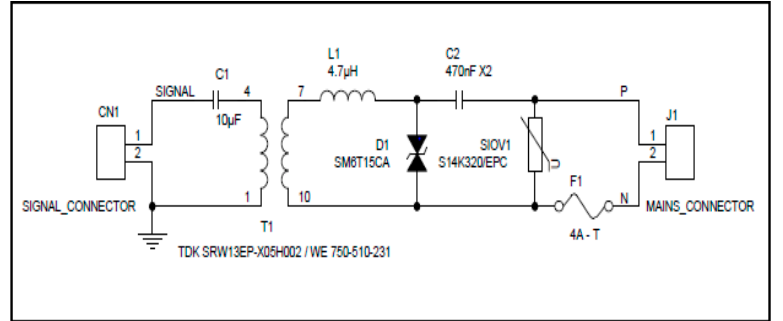
Figure 3. Steval PLC Coupling Circuit.